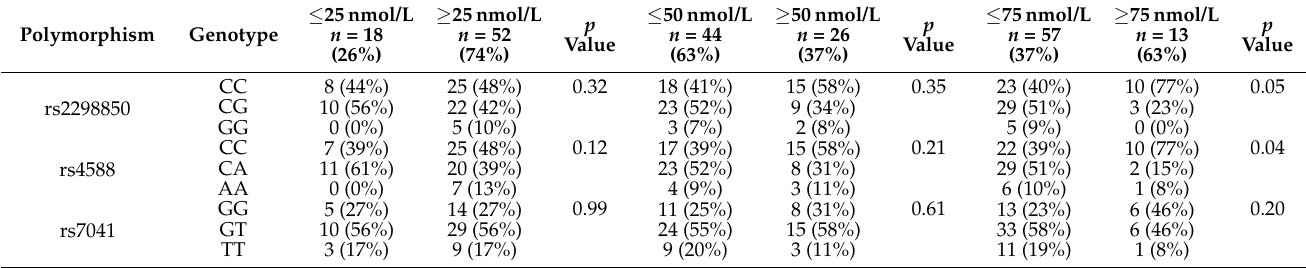
Table 8. Maternal vitamin D status at birth (cut-offs at birth ≤ 25 vs. ≥ 25 nmol/L, ≤ 50 vs. ≥ 50 nmol/L and ≥ 75 nmol/L vs. ≤ 75 nmol/L) according to maternal VDBP